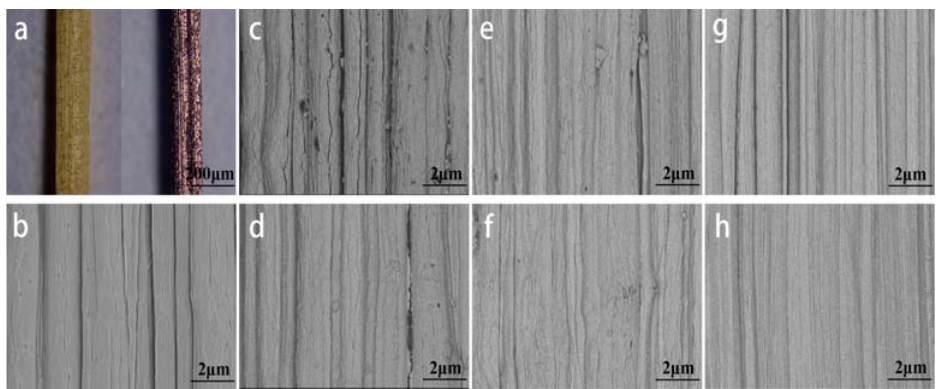
Figure 1. Microscopic picture of bamboo fiber bundle. ( a ) Stereomicroscope picture of CK and 150- 9. ( b – h ) SEM images of CK and samples after magnetron sputtering: ( b ) CK, ( c ) 100-6, ( d ) 150-6, € 100-9, ( f ) 150-9, ( g ) 100-12, ( h ) 150-12.